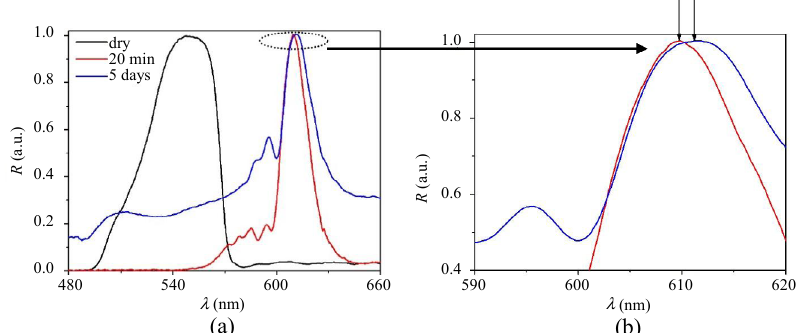
Fig. 3 Results of glycerol impregnation: (a) normalized reflectance spectra of 1D PhC based on AAO in the dry state (black line), after 20 minutes impregnation with glycerol at 70 ℃ (red line) and after additional impregnation with glycerol for 5 days at room temperature (blue line) and (b) reflectance peaks after different impregnation methods, shown in close-up. The spectral positions of the maxima (609.5 nm and 611.4 nm for red and blue curves, correspondingly) are indicated by